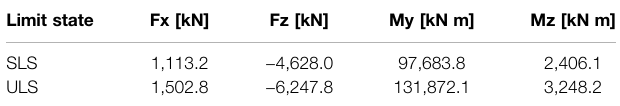
TABLE 2 | Structural loadings with partial safety